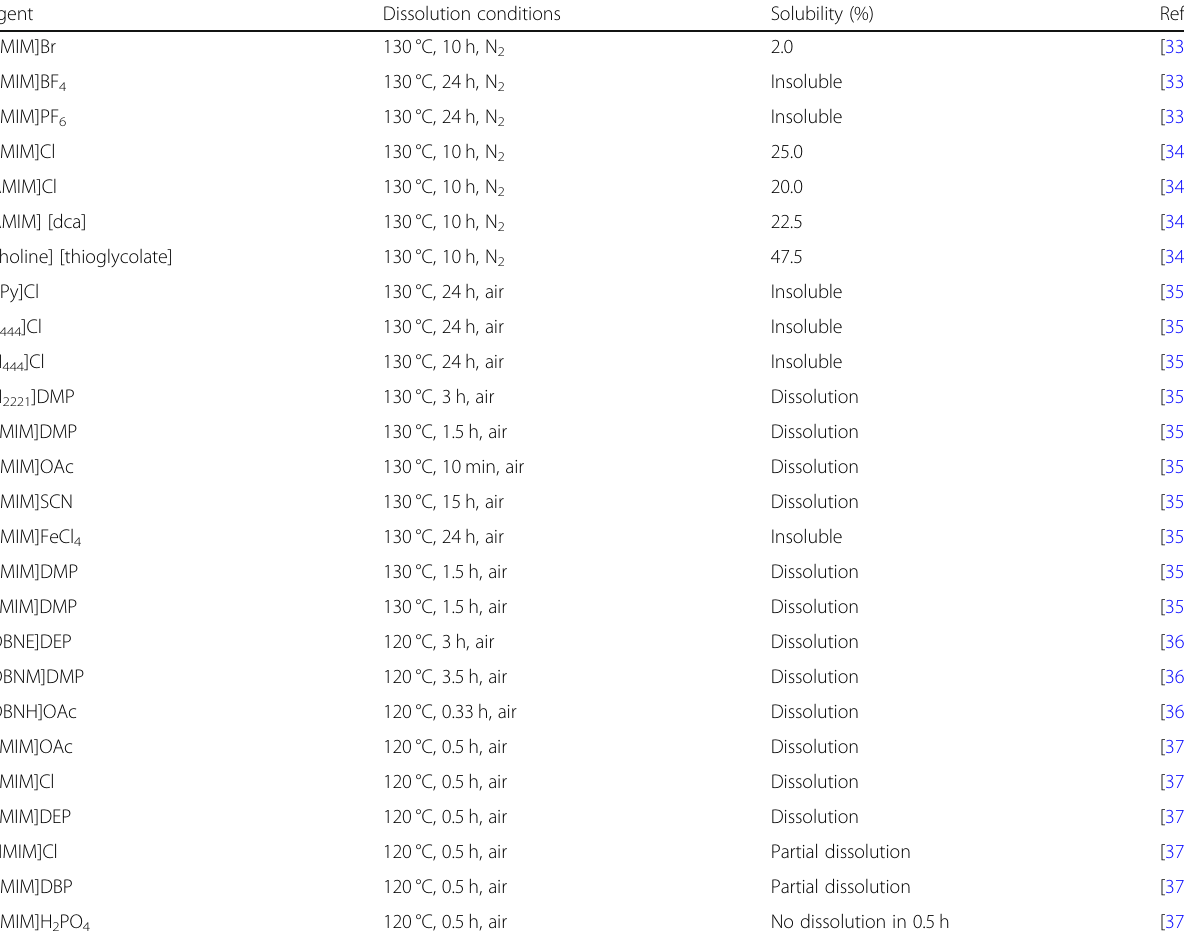
Table 1 Characteristics of wool keratin dissolution conditions using the ILs method Agent Dissolution conditions Solubility (%) Ref. [BMIM]Br 130 °C, 10 h, N